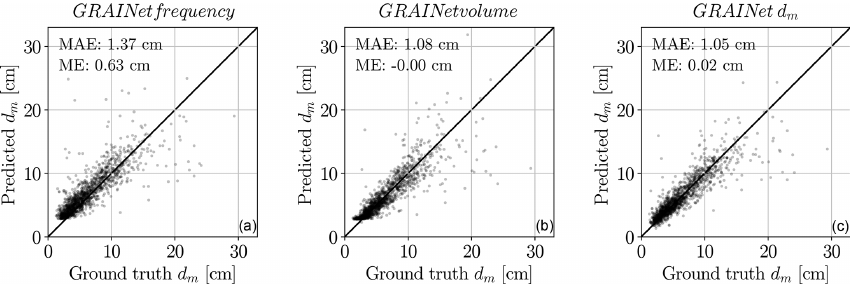
Figure 13. Scatter plots of the estimated d m [cm] from the three GRAINet outputs: frequency , volume , and d m (left to right). The ground truth d m is on the horizontal axis, and predicted d m is on the vertical axis.